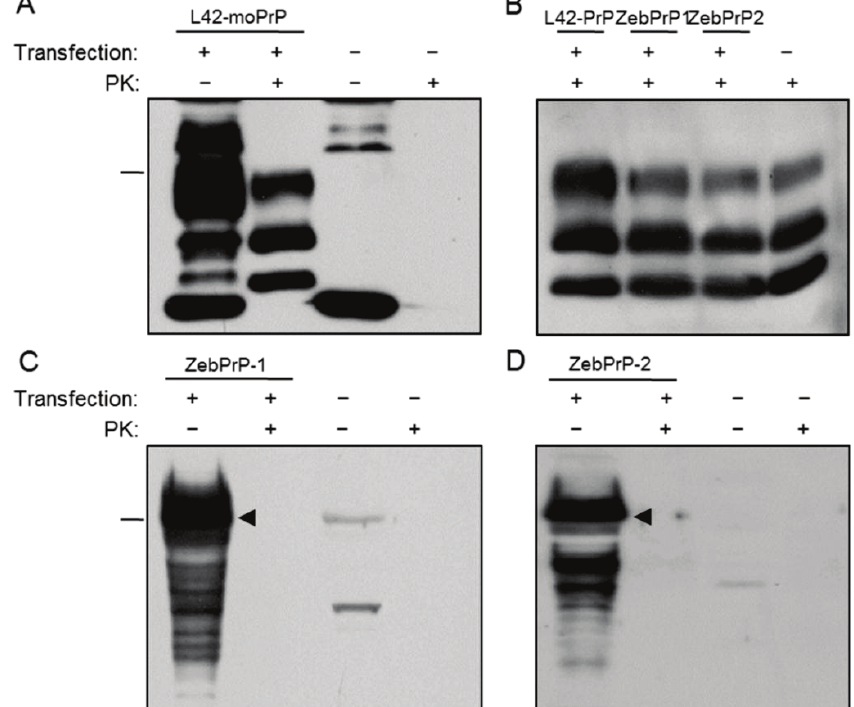
Figure 5. Mature ZebPrP1 and ZebPrP2 exhibit no PK-resistance in the 22L-ScN2a cell line. Western blot analysis of 22L-ScN2a cells transfected with mouse or fish recombinant proteins (transfection +) and non-transfected (transfection −) control cells. ( A ) Positive conversion control, cells transfected with L42-moPrP (L42, 1:10); ( B ) Endogenous PrP Sc , cells transfected with fish and mouse PrPs (6H4, 1:5000); ( C ) ZebPrP-1 conversion potential (ZebPrP1, 1:750); ( D ) ZebPrP-2 conversion potential (ZebPrP2, 1:1500). PK concentration, 5 μg/m L. Arrowheads indicate the fish proteins of interest. Relative molecular mass markers, 32.5 kDa ( A , B ), 62 kDa ( C , D